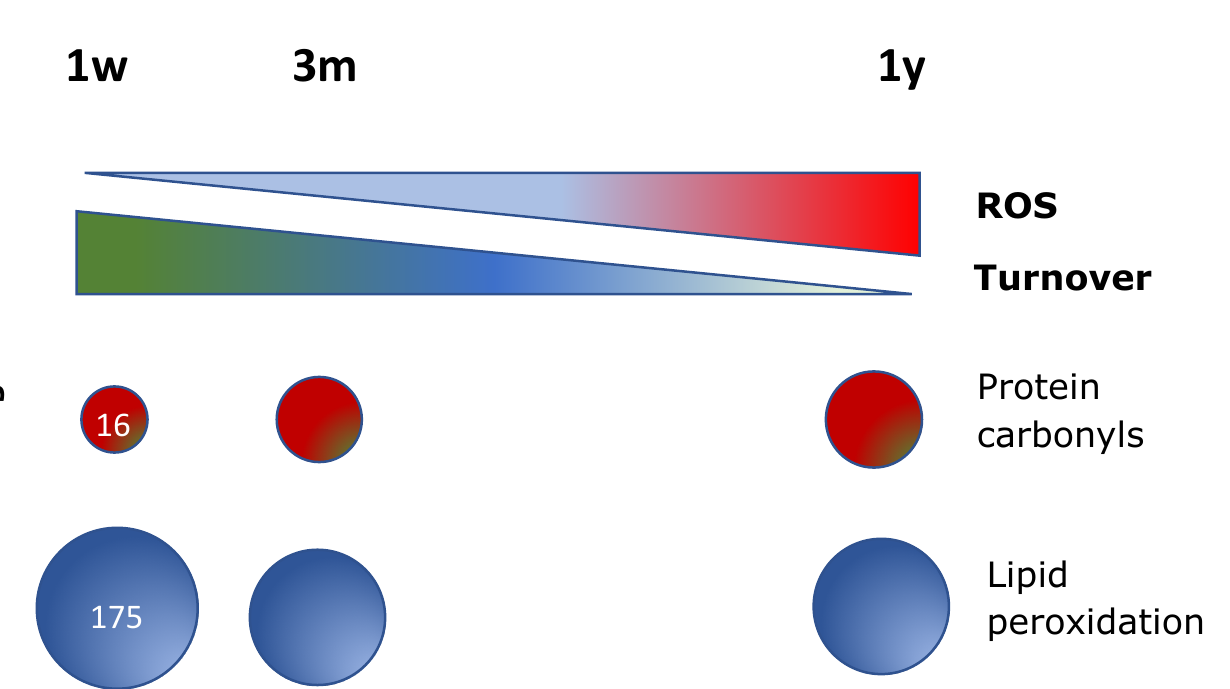
Figure 4. Oxidative stress is a driving force for homeostatic turnover in mouse heart . Total levels of reactive oxygen species (ROS) and regeneration capacity (turnover) are compared in mice aged 1- week, 3-months and 1-year. Levels of molecular damage (protein carbonyls and lipid peroxidation [malondialdehyde; MDA]) were evaluated at those ages. Numbers (1 week) correspond to the levels ( µ M) of carbonyls and MDA; the surface of the indicated circles are proportional to the quantitative evaluation.